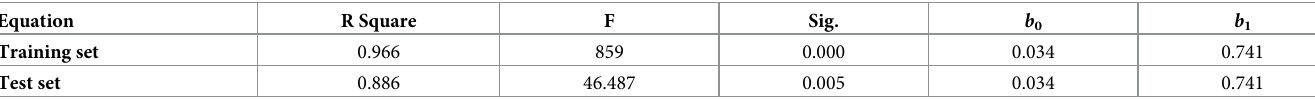
Table 3. Estimated parameters of cumulative confirmed cases of COVID-19.